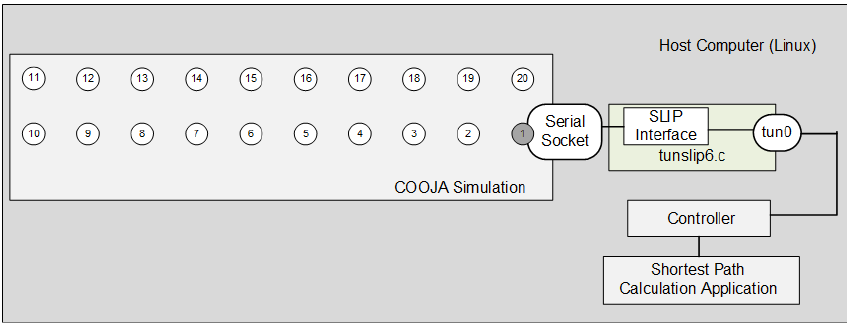
Figure 16. Integration between the COOJA simulation and the host